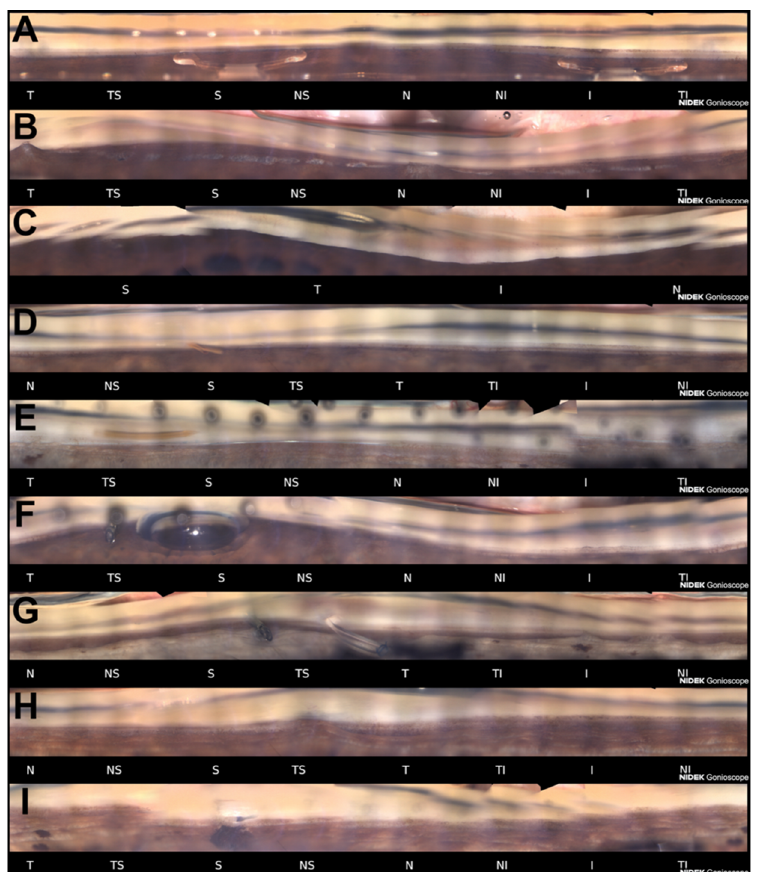
Figure 2. Examples of pathological and post-surgical findings imaged with GS-1. ( A ) Angle- supported phakic lens used in the past to correct myopia. Angle is open and moderately pigmented; ( B ) This eye was recently treated with phacoemulsification for angle closure. Previously, argon laser peripheral iridoplasty was performed. Some peripheral anterior synechiae are visible (T, N); ( C ) Angle closure. No angle anatomical structures are identifiable; ( D ) XEN gel stent implanted in a patient affected by exfoliative glaucoma (S). The ciliary band is visible for the majority of the angle. Sampaolesi line is well identifiable in the inferior quadrant; ( E ) XEN gel stent implanted after a failed ab externo canaloplasty (S). A 10-0 prolene suture in the Schlemm’s canal had been placed to maintain the canal under tension and therefore patent; ( F ) Ex-PRESS filtration device imaged few hours after the surgery (TS). A small air bubble is still present in the superior quadrant; ( G ) After a failed flap Ex-PRESS surgery, a Baerlveldt drainage device was implanted (TS). The tube is still closed by a prolene suture placed to prevent hypotony in the early postoperative period; ( H ) Deep sclerectomy with iris adhesion to the filtrating area (TS). Emulsified silicone oil is identifiable in the superior quadrant; ( I ) Iridectomy and the patent internal ostium of a trabeculectomy (S). Anterior chamber angle sectors: T = Temporal; TS = Temporal-Superior; S = Superior; NS = Nasal-Superior; N = Nasal; NI = Nasal-Inferior; I = Inferior; TI = Temporal-Inferior.